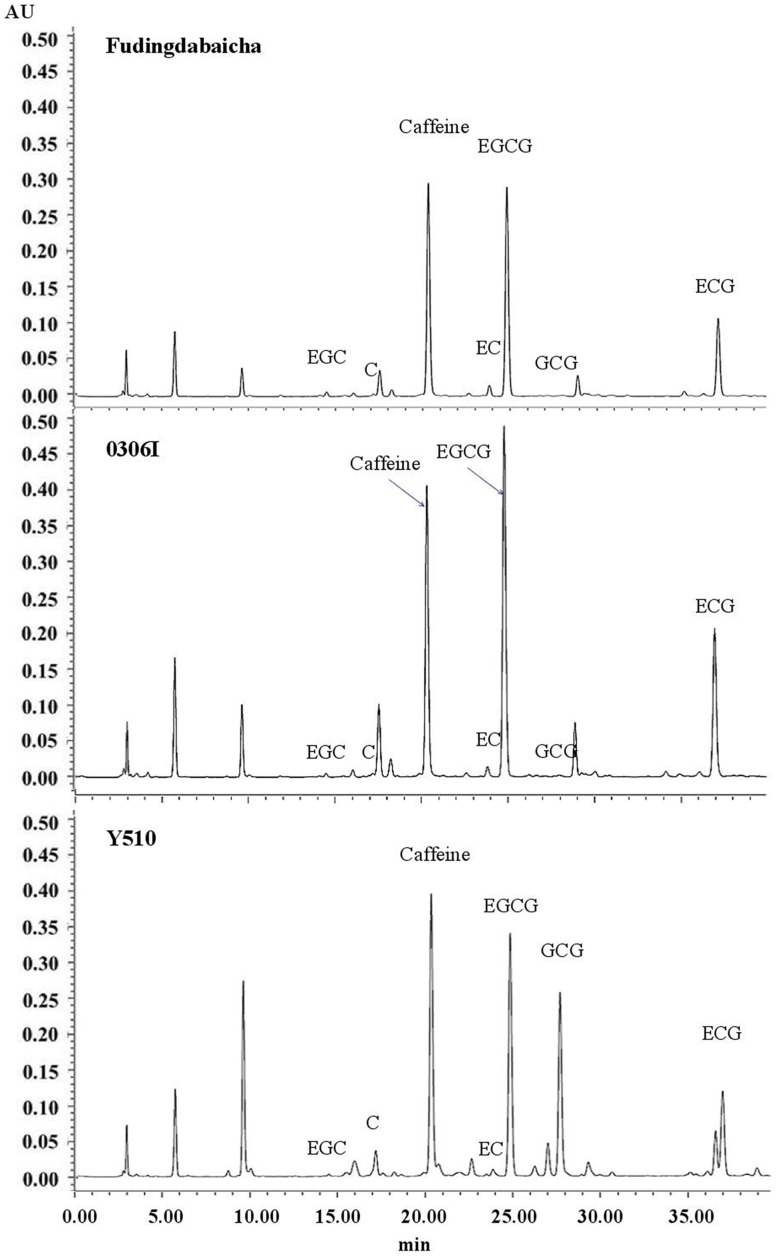
HPLC chromatogram of catechins of three tea cultivars: Fudingdabaicha, 0306I and Y510.